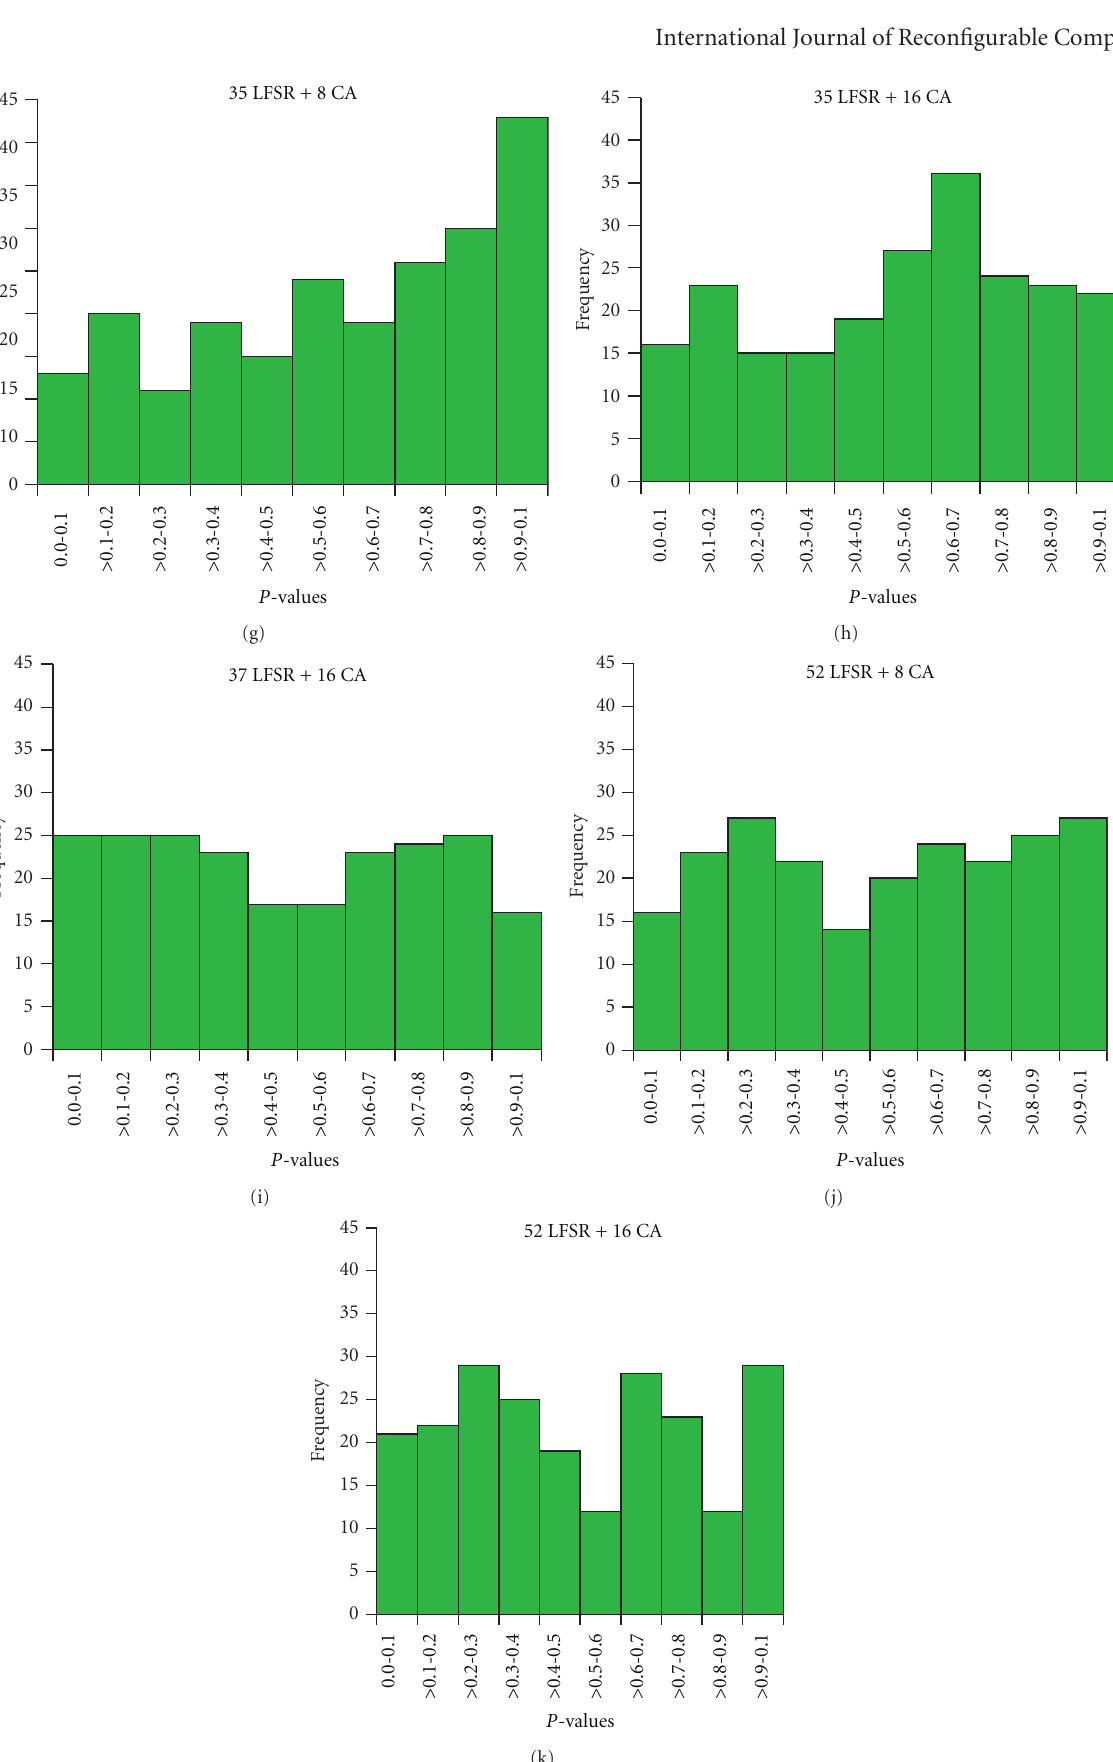
Figure 9: The P -value distributions obtained from the D iehard test